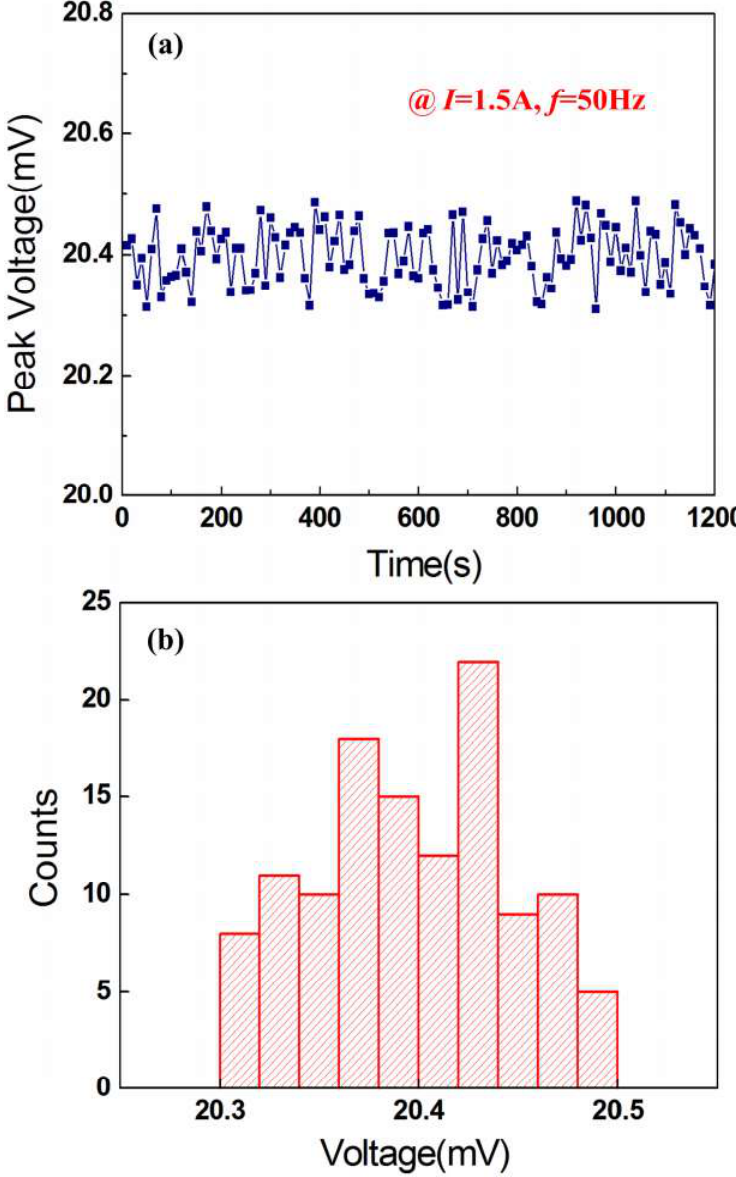
Figure 5. ( a ) Induced voltage versus time at 50 Hz for d = 0 mm and ( b ) Histogram for the voltage at 1.5 A.